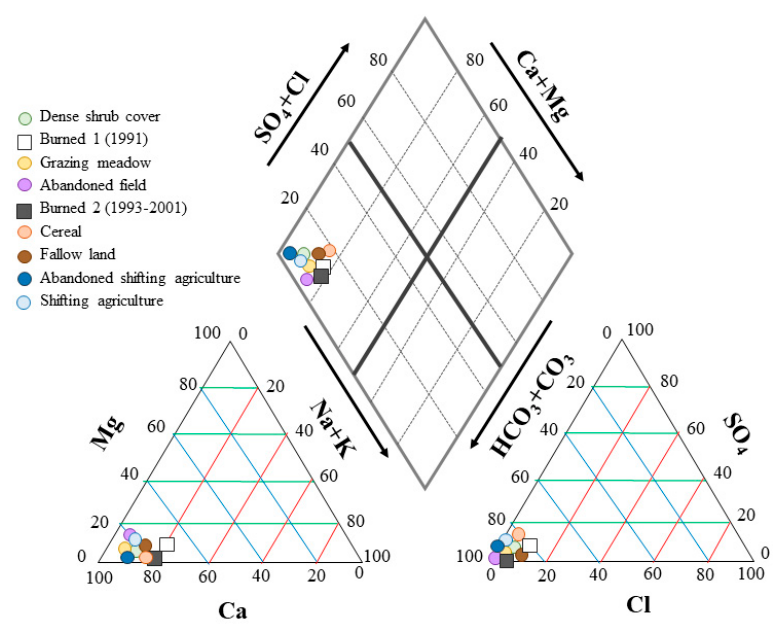
Figure 4. Piper diagram with mean solute losses from various land uses for the period 1991-2011.